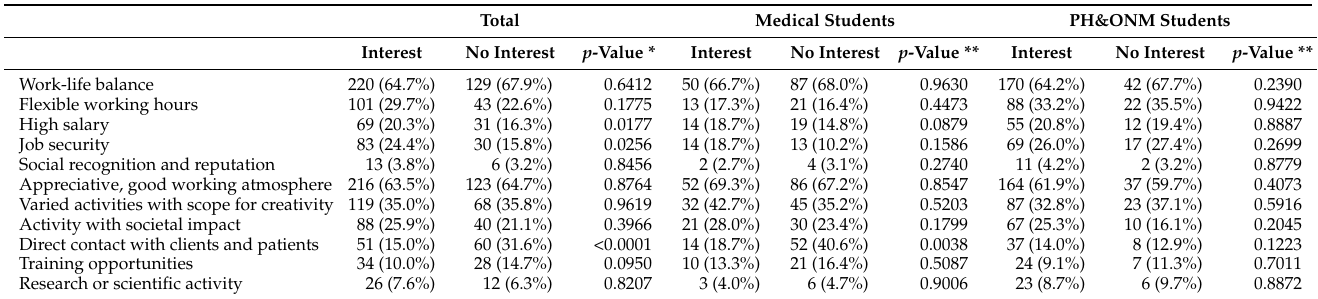
Table A7. Expectations for future working life and career: Absolute and relative proportion of grouped responses by field of study and PHS interest in wave 2,